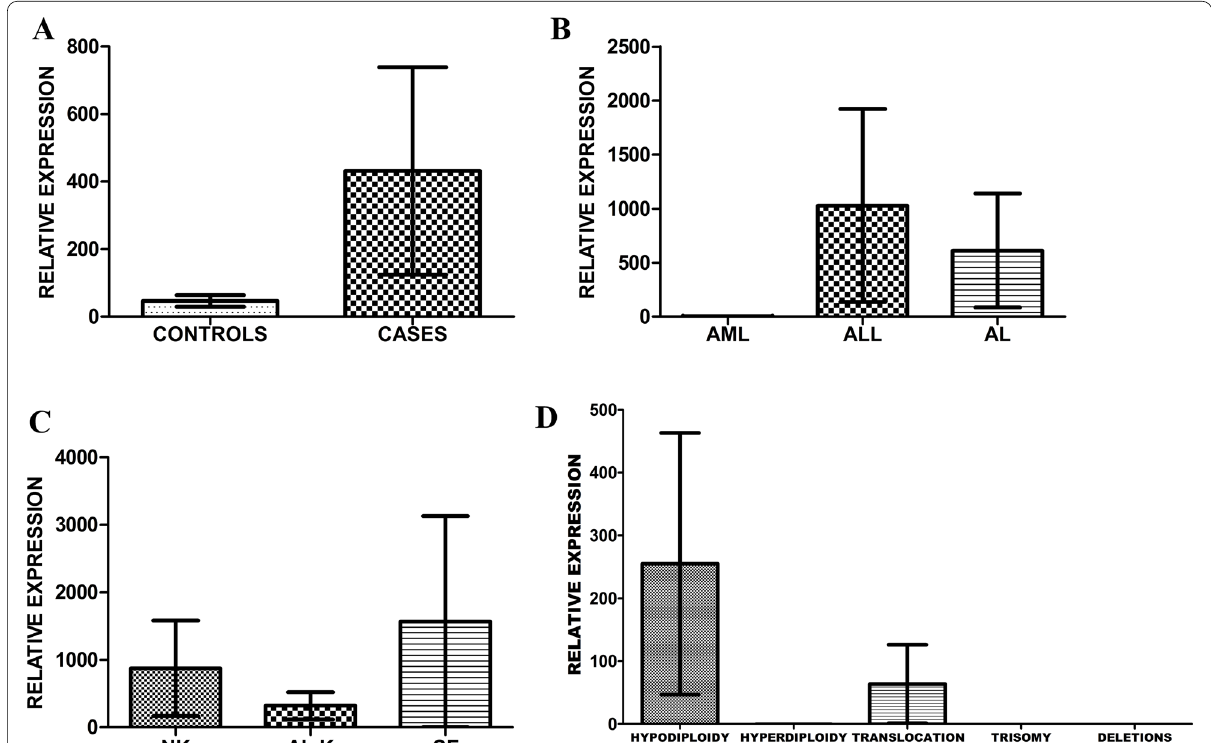
Fig. 1 A Comparison of PRAME gene expression between patients and controls. B PRAME gene expression in acute leukemia classification. C PRAME gene expression based on cytogenetic analysis. D PRAME gene expression in various abnormalities of cytogenetic